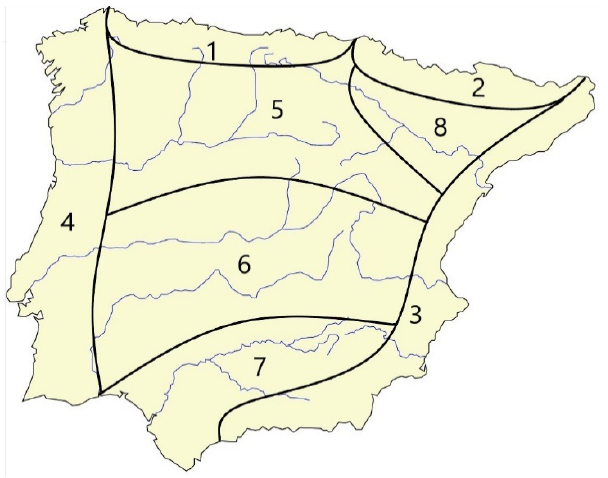
Figure 1. Aprioristic refugium areas considered in the Iberian Peninsula. 1. Cantabric; 2. Pyrenean; 3. Mediterranean coast; 4. Atlantic; 5. Northern plateau; 6. Southern plateau; 7. Guadalquivir Valley; 8. Ebro Valley.